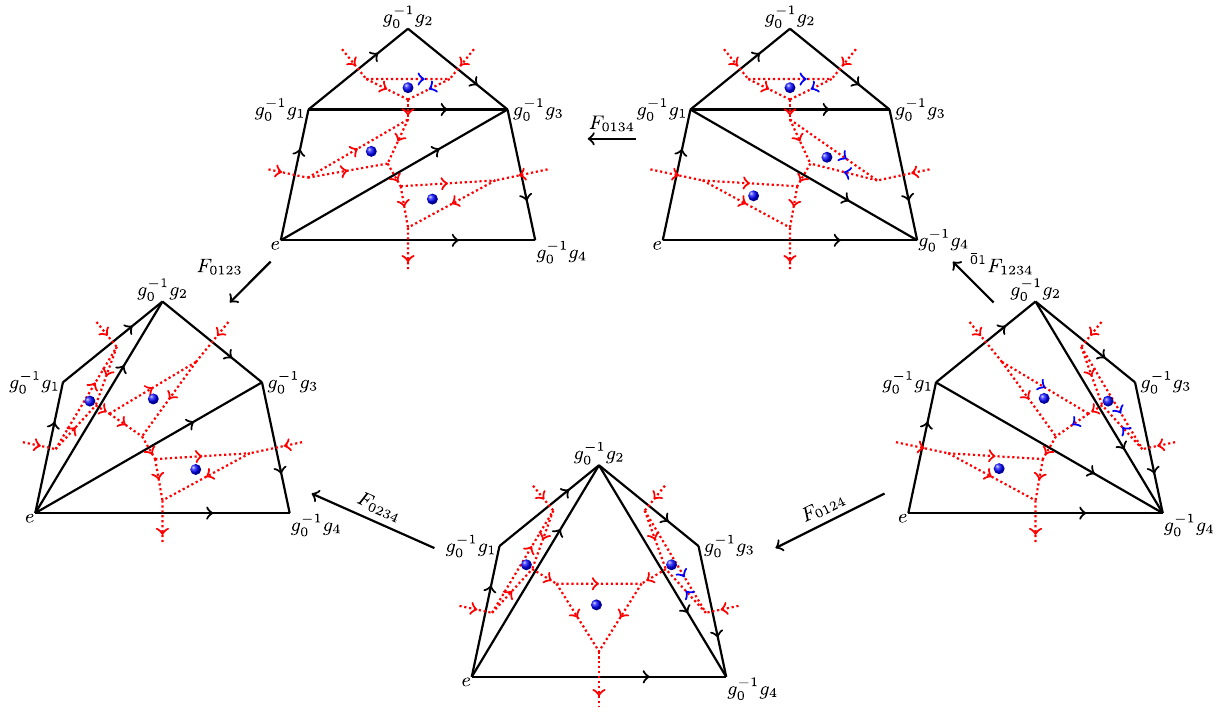
FIG. 3. Standard superpentagon equation. The dual trivalent graph of the triangulation is the usual string diagram pentagon equation for the tensor category. Algebraically, this standard superpentagon condition corresponds to Eq. (129). Since the group element label of the first vertex is e ∈ G , all the fermionic F moves are standard except b ¯ F ð e; ¯ ij; ¯ jk; kl Þ in the figure. Blue arrows indicate that the Majorana fermion pairing directions may be changed compared to the red arrow Kasteleyn